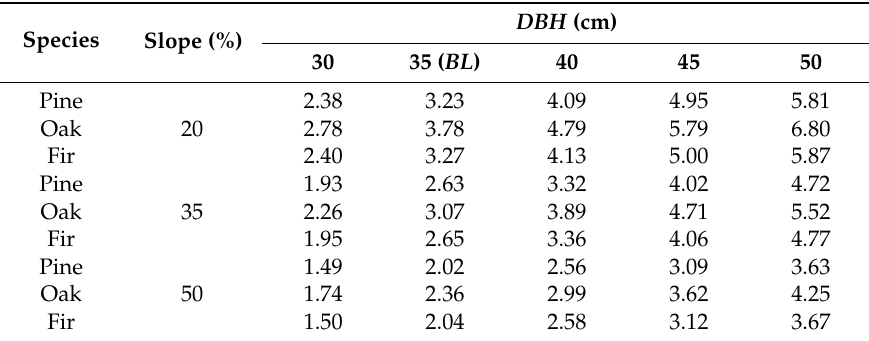
Table 14. Productivities for manual felling using chainsaw according to species, slope class, DBH and D factor (m 3 /h).